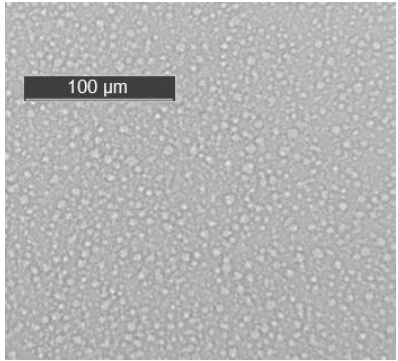
Figure 2. Morphology of the uncured ELP system.